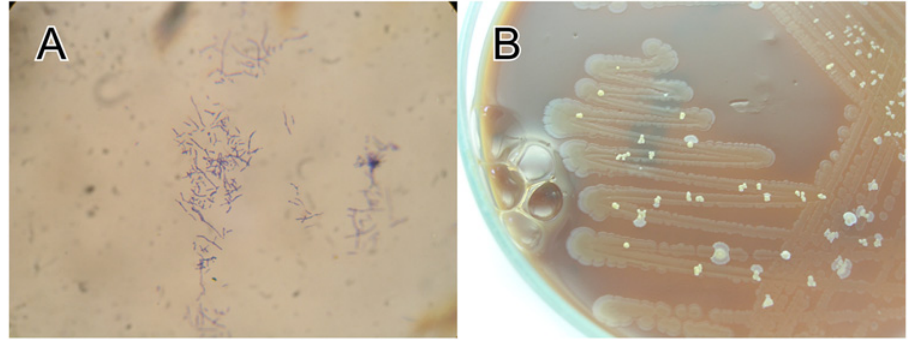
Fig 3. (A) Gram stain preparation showing branching Gram-positive rods, (B) Chocolate agar showing heavy growth of Staphylococcus aureus with scattered colonies of Nocardia aobensis (5 days ’